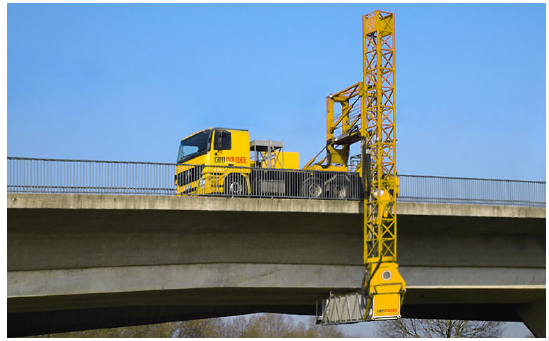
Figure 2. By-bridge